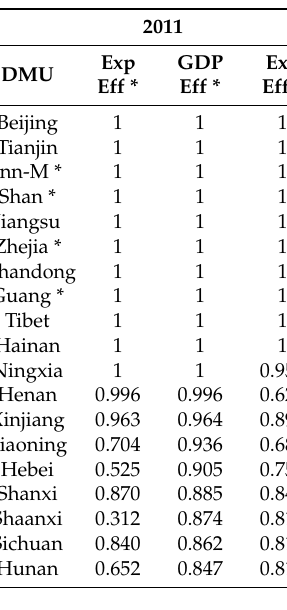
Table 3. Efficiency results of inputs from 2011 to